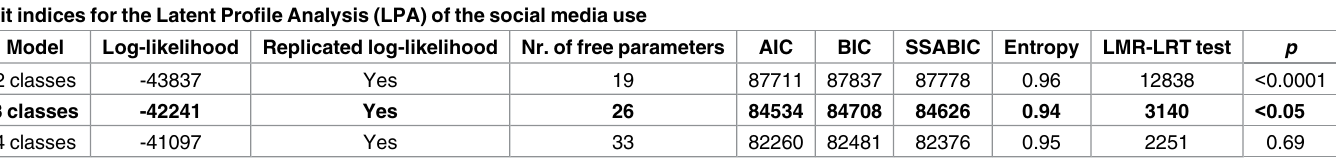
Table 1. Results of the Latent Profile Analysis.